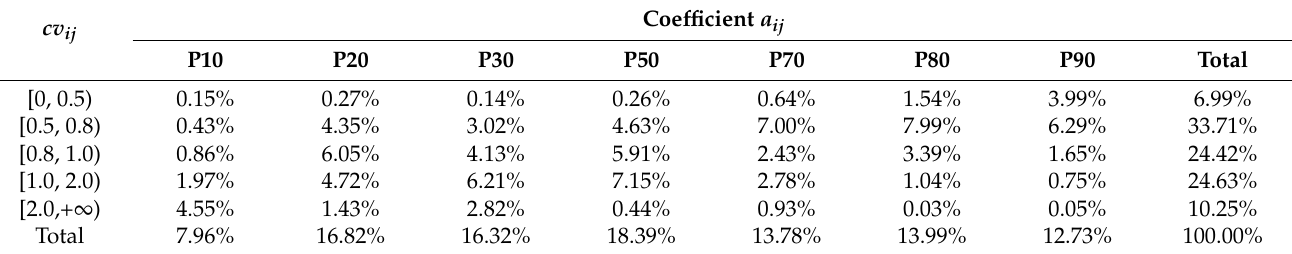
Table 3. Coefficients of variation (our method).